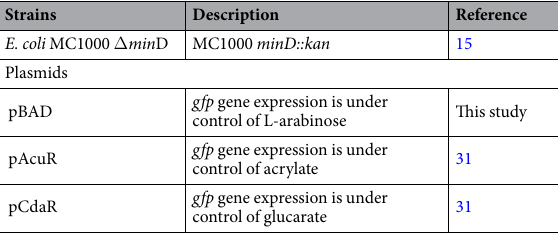
Table 2. Bacterial strain and plasmids used in this